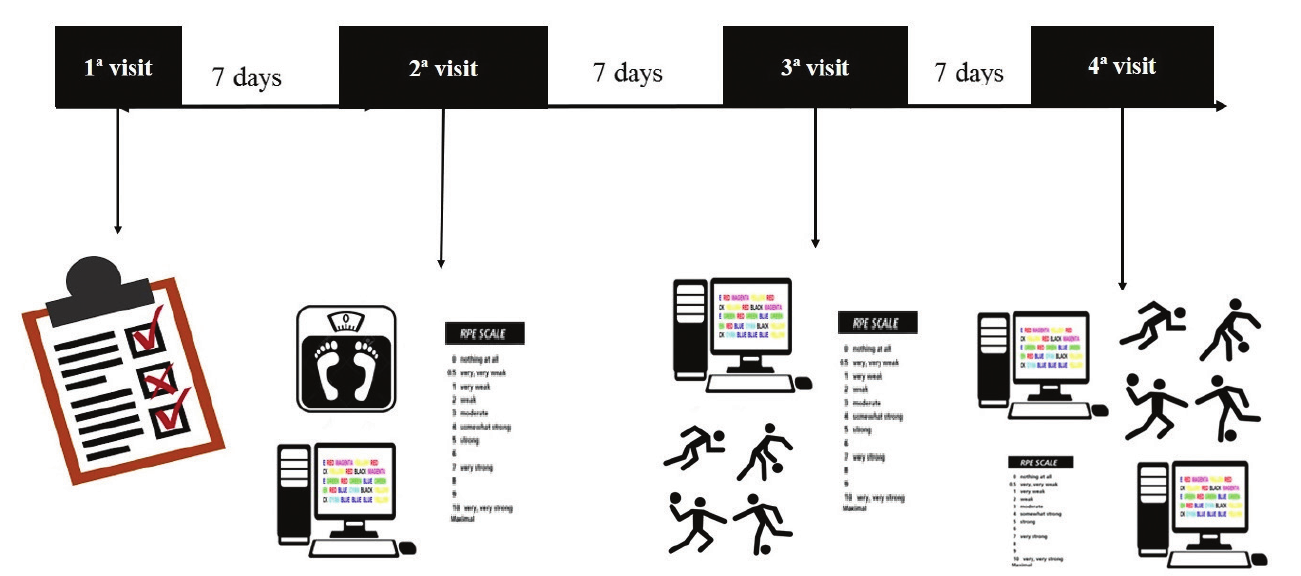
Figure 1. Experimental design